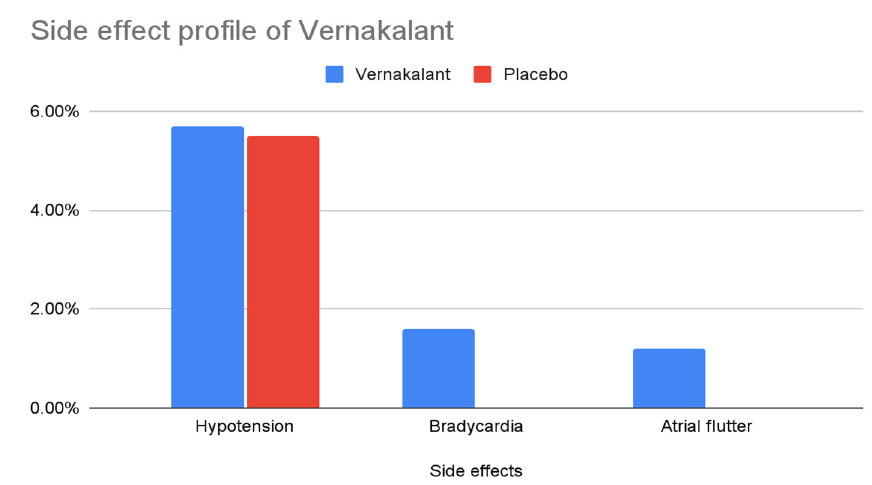
Figure 3. The side effect profile of vernakalant.